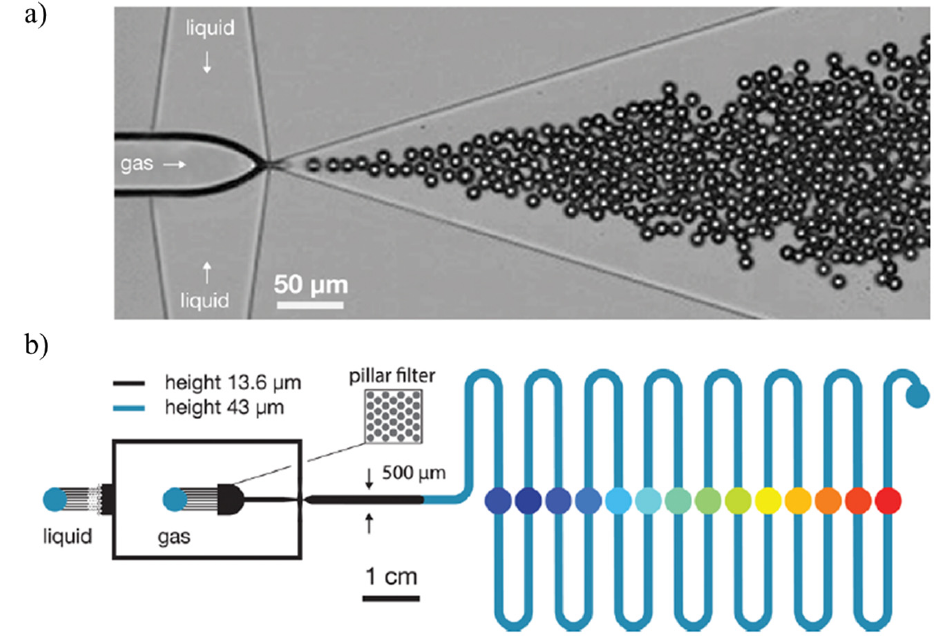
Figure 2. Bubble formation at a rate of 6 × 10 4 bubbles/s from a flow focusing ( a ) connected to a serpentine channel 15 cm in length ( b ) to characterize the bubble stability over the first minute after their formation. Reproduced with permission from [78] (Copyright © 2016, American Chemical So ‐ ciety).